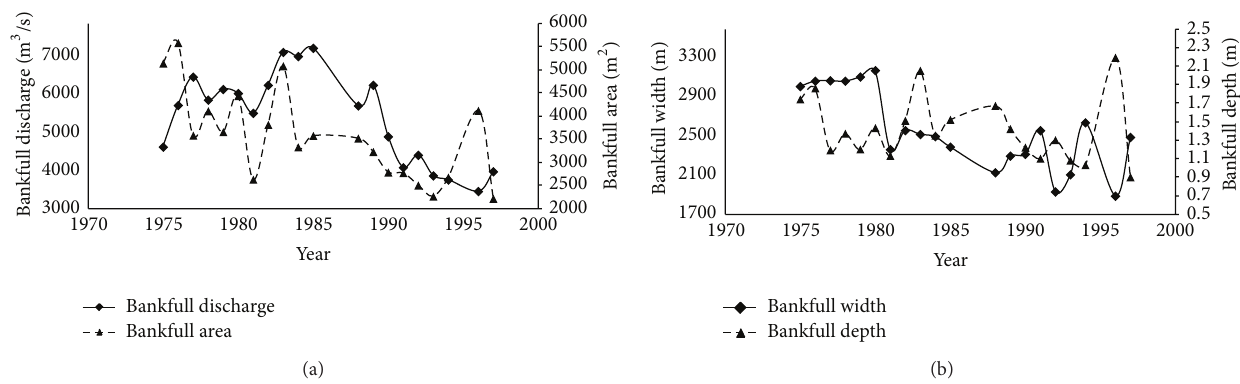
Figure 7: Observed bankfull characteristics at Huayuankou Station: (a) bankfull discharge and area; (b) bankfull width and depth.